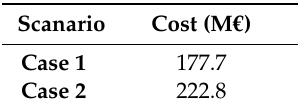
Table 12. Converter stations estimated costs in the two cases analyzed.